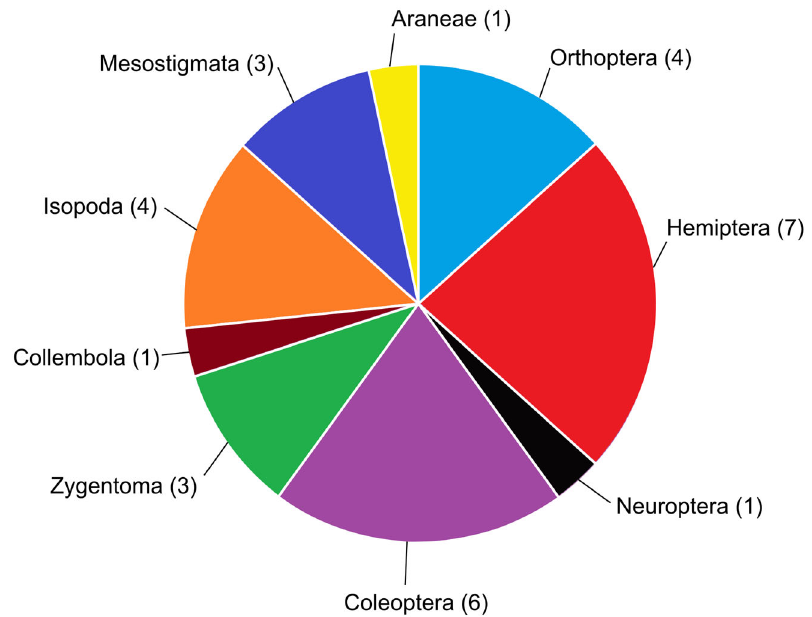
Figure 6. Pie chart showing representation of each arthropod group found to be intranidal myrme- cophiles in the Maltese Islands; the number in parentheses denotes the number of intranidal myrme- cophilous species from each group which occur in the